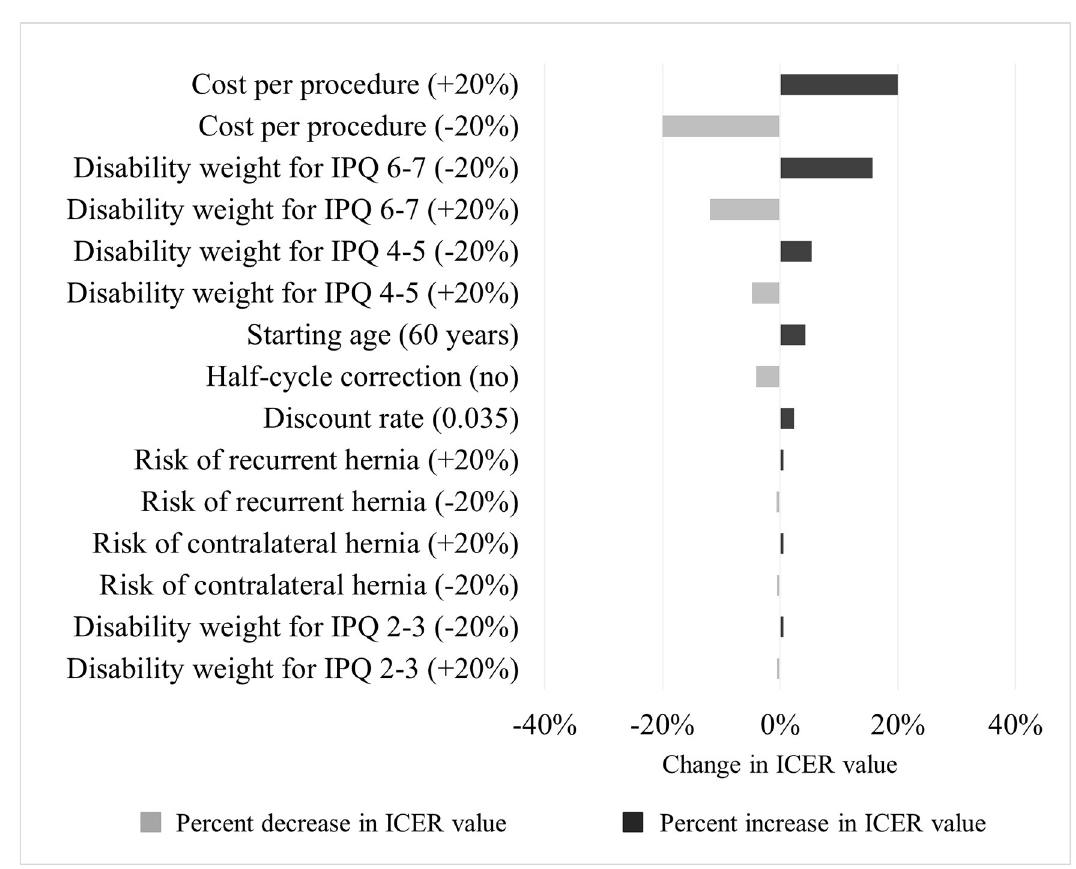
Fig 2. Deterministic sensitivity analysis of incremental cost-effectiveness ratios (ICERs). The tornado chart displays percent decrease or increase in ICER value from variations of inputs to the